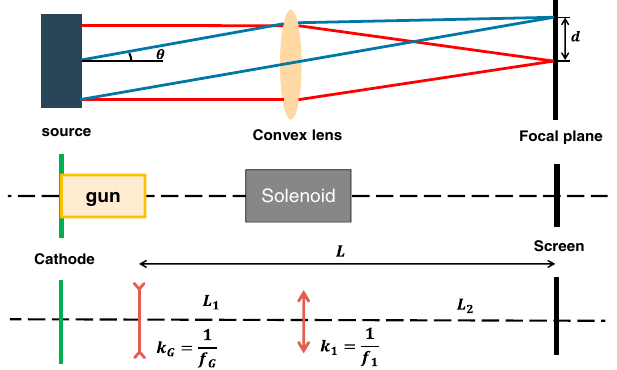
FIG. 1. The basic concept of the cathode transverse momentum imaging. θ is the angle between the light trajectory and horizontal line. d is the distance between the hitting point and image center. A simplified electron beam line is set up. The first element is the rf gun with a defocusing lens of strength k G . After a drift of distance L 1 , the second element is a focusing lens with k 1 . Then comes another drift L 2 and the final element is the screen. L is the sum of L 1 and L 2